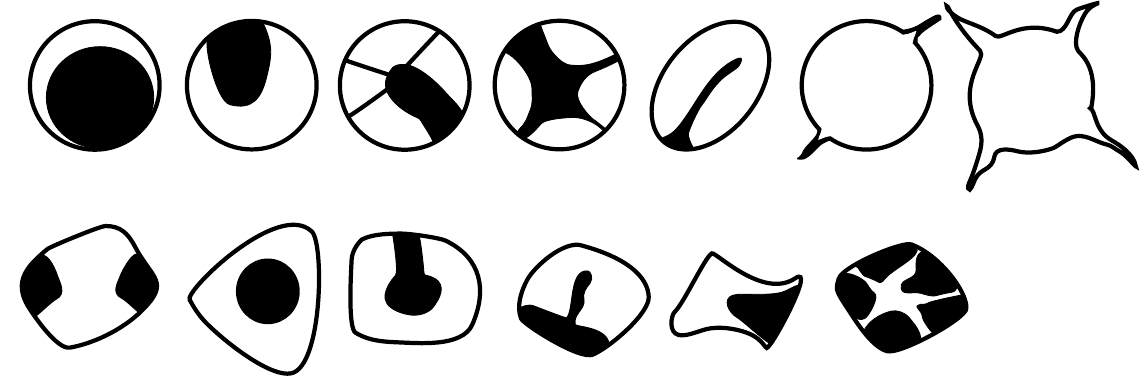
Fig. 2. Milnesium pelufforum sp. nov. Schematic drawing of cuticular dimples showing their shapes and different appearances of internal